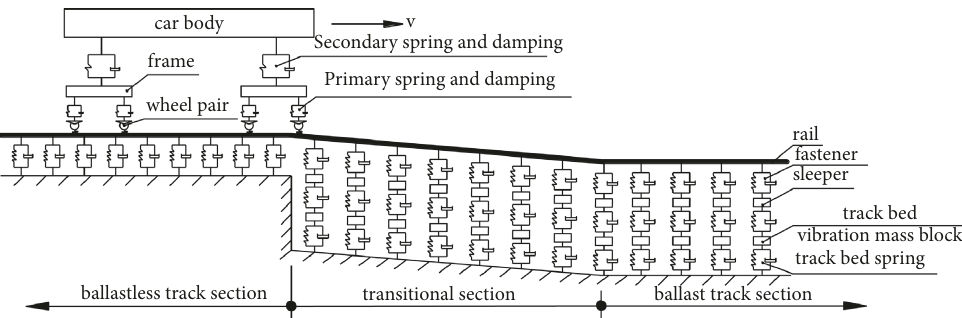
Figure 5: Vehicle-track dynamics model.